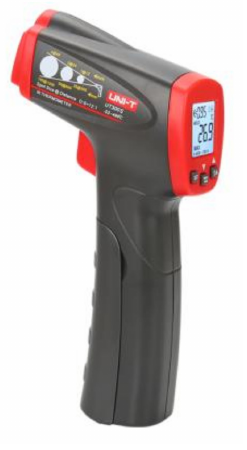
Figure 14. UT300S Infrared Thermometer